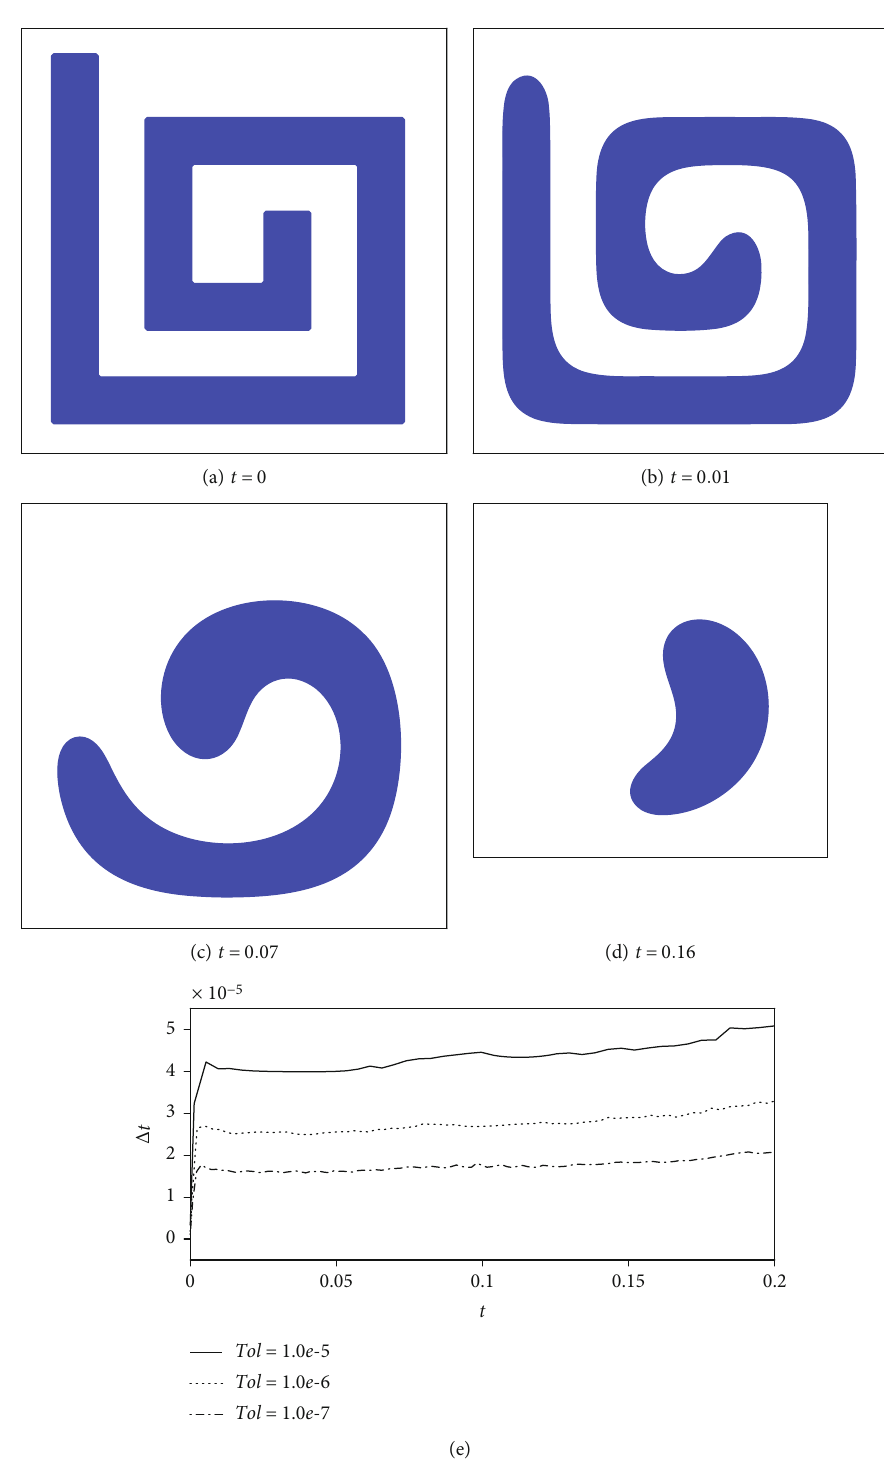
Figure 8: (a – d) Snapshots of the 2D spiral shape at time t = 0, 0 : 01, 0 : 07, and 0 : 16 , respectively. (e) Changes of Δ t over time t according to three di ff erent tol